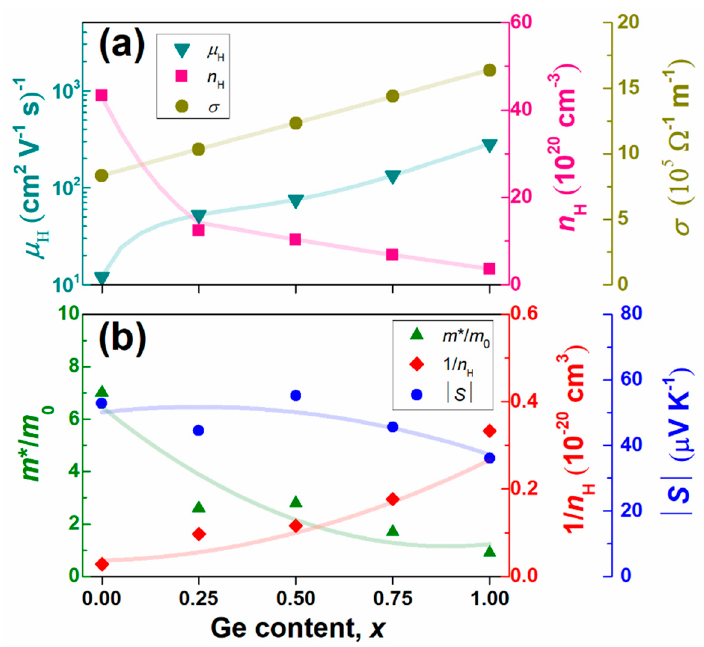
Figure 8. Composition dependences of ( a ) the Hall mobility µ H , Hall concentration n H , and electrical conductivity σ (= e · µ H · n H ) and ( b ) absolute S | S |, effective mass m */ m 0 , and 1/ n H for Yb(Si 1 − x Ge x ) 2 −δ (0 ≤ x ≤ 1.0). All symbols represent experimental data obtained at 300 K. The lines are guides to the eye. Reproduced with permission from Ref. [36]. Copyright 2018, AIP Publishing.